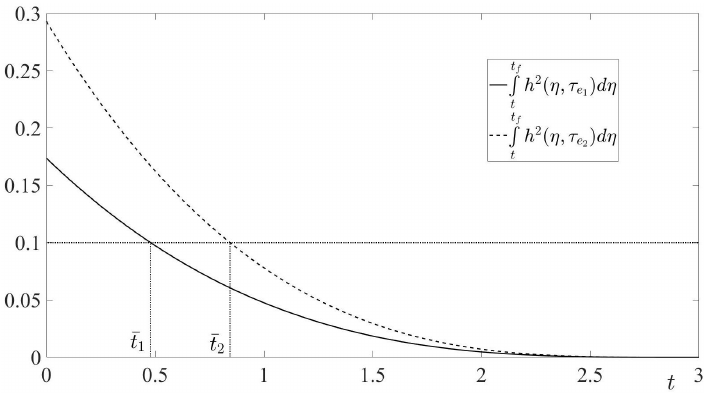
Figure 1. Moments ¯ t i ( β )